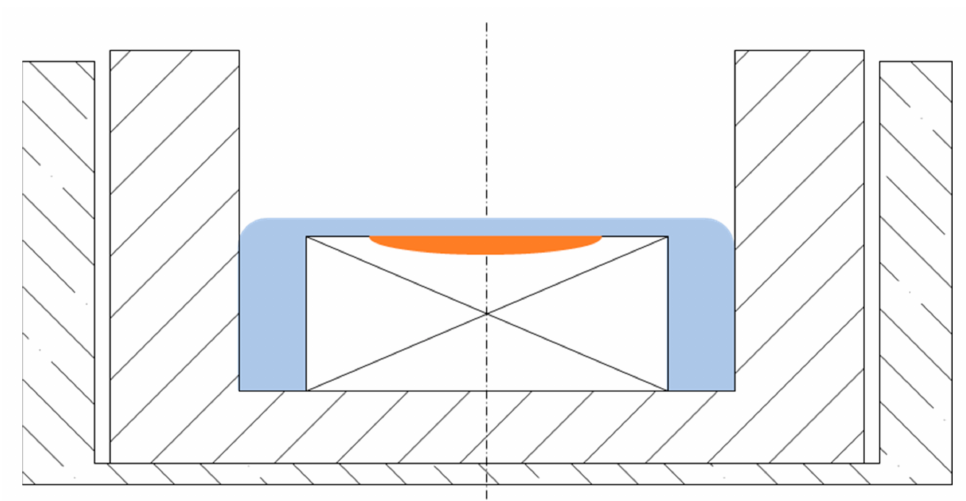
Figure 3. Set-up during experiment liquid steel pool covered by molten slag.